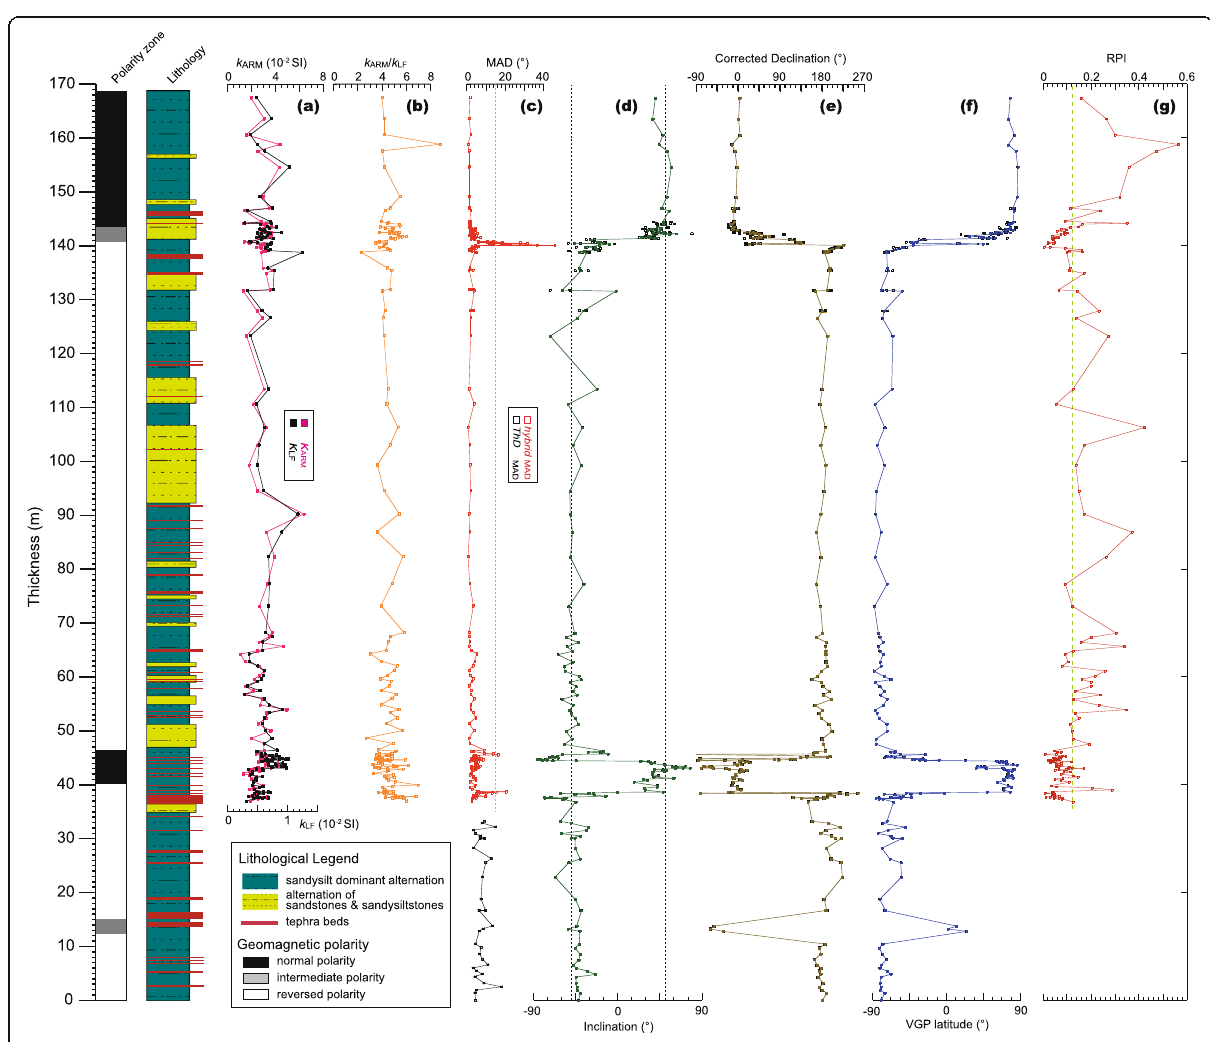
Fig. 5 Stratigraphic profiles for paleomagnetic directions and rock-magnetic properties. Note that the data plotted below 36-m thickness are obtained by the pThD method, not the hybrid method. a k ARM and k LF values. b k ARM / k LF values. c MADs associated with calculations used to deduce the ChRMs. The green dashed line indicates 15°, i.e., the maximum limit for using the deduced ChRMs. d Inclination values. The dashed lines indicate the geocentric axial dipole inclinations for normal and reversed polarities. e Declinations with the corrected tectonic rotation of 8.6° are shown in circles. f VGP latitude. g RPI values. The green dashed line indicates the average RPI value for the entire interval of this study. For ( d , e , and f ), the solid square shows a site-mean value, or a single value if the only ChRM is available at a site, whereas the open square shows a single value used to deduce a site-mean